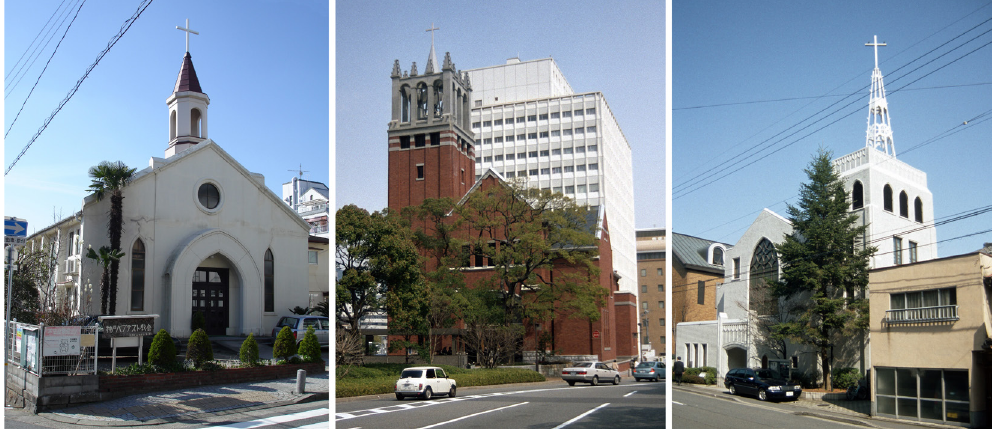
“CHURCHLY” CHURCHES IN JAPAN: BAPTIST CHURCH IN KOBE (1953), EIKO CHURCH KOBE (2004), RAKUYO CHURCH IN KYOTO